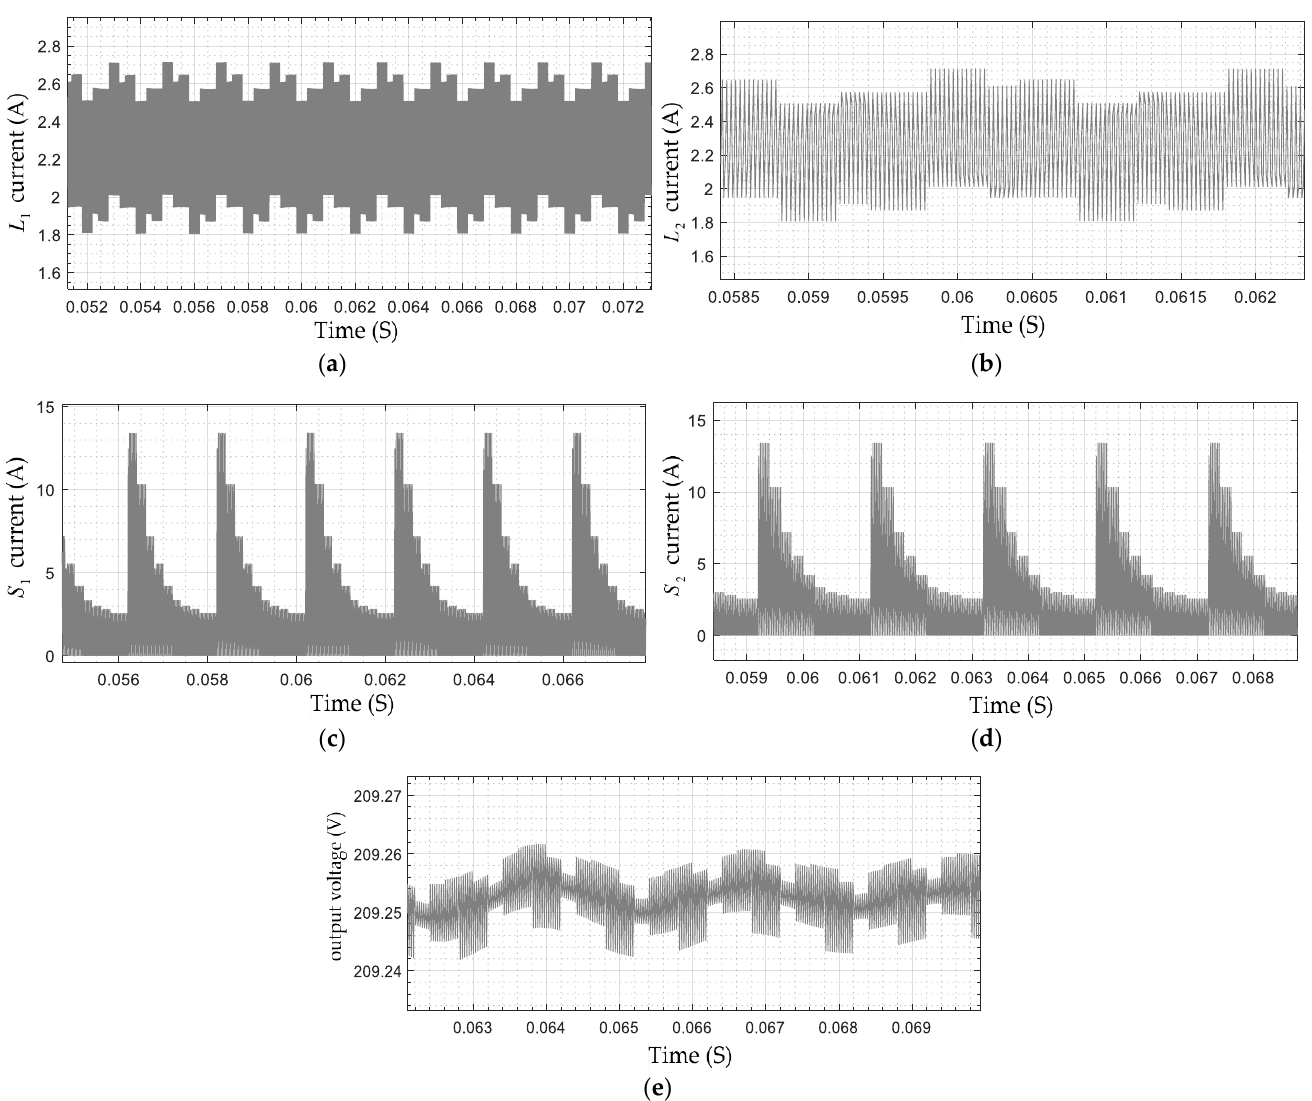
L current, ( b ) 1 current, ( b ) L 2 current, ( c ) S 1 current, ( d ) S 2 current, and ( e ) output 1